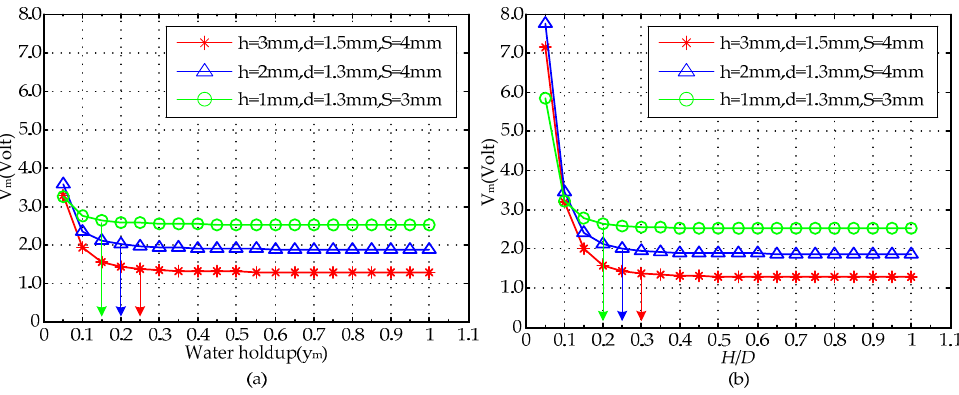
Figure 14. FEM calculated response of the MCP with D = 20 mm for segregated flow: ( a ) V m versus y m ; ( b ) V m versus H/D .